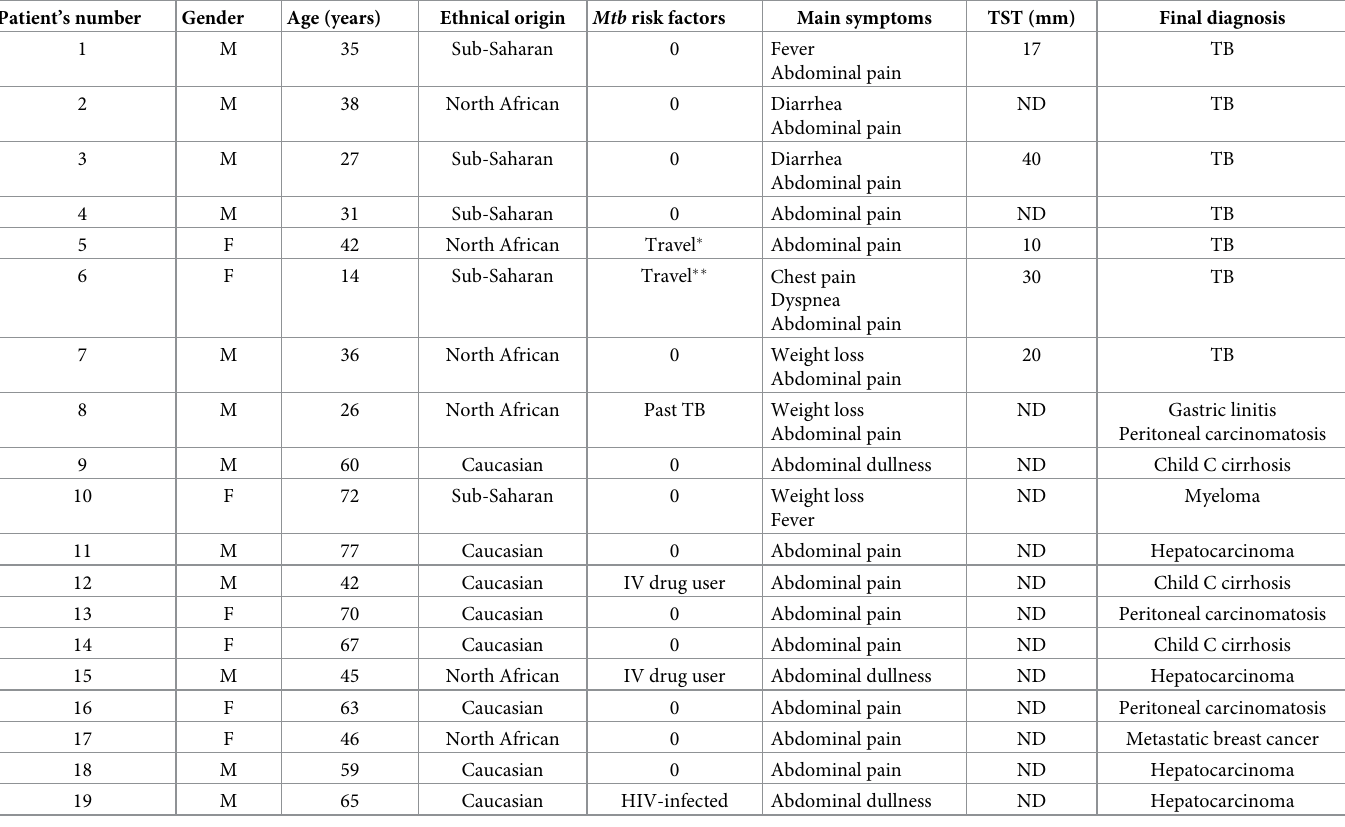
Table 1. Demographic and clinical characteristics of included